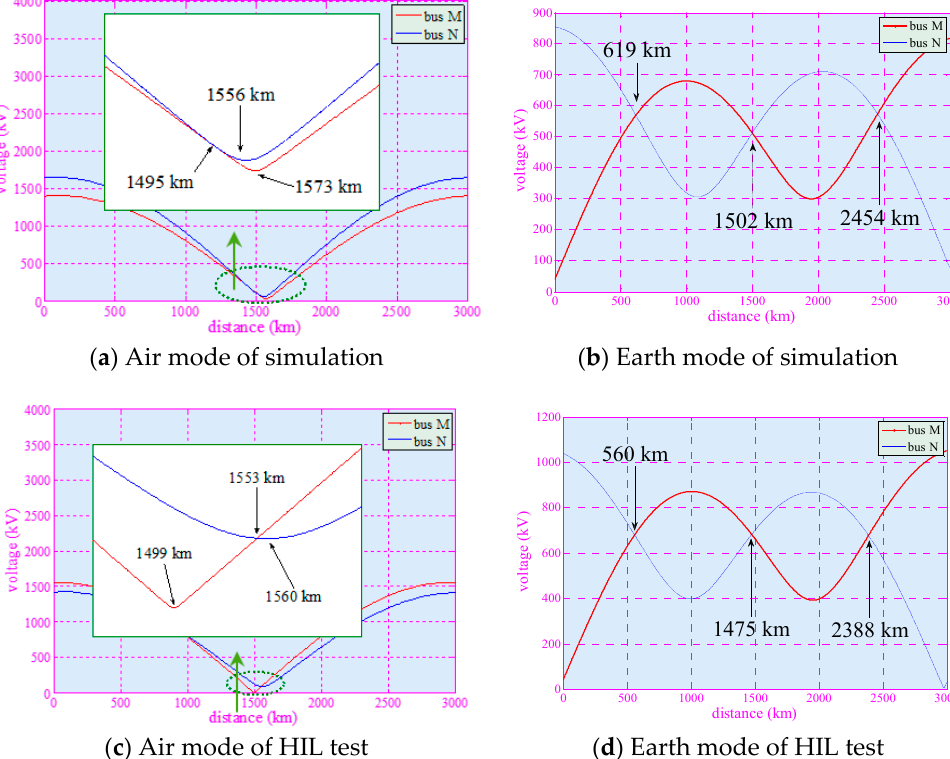
Figure 12. A double phase-to-ground (ABG) fault with 50 Ω fault resistance, 1500 km away from bus M, with 400 MW wind power.